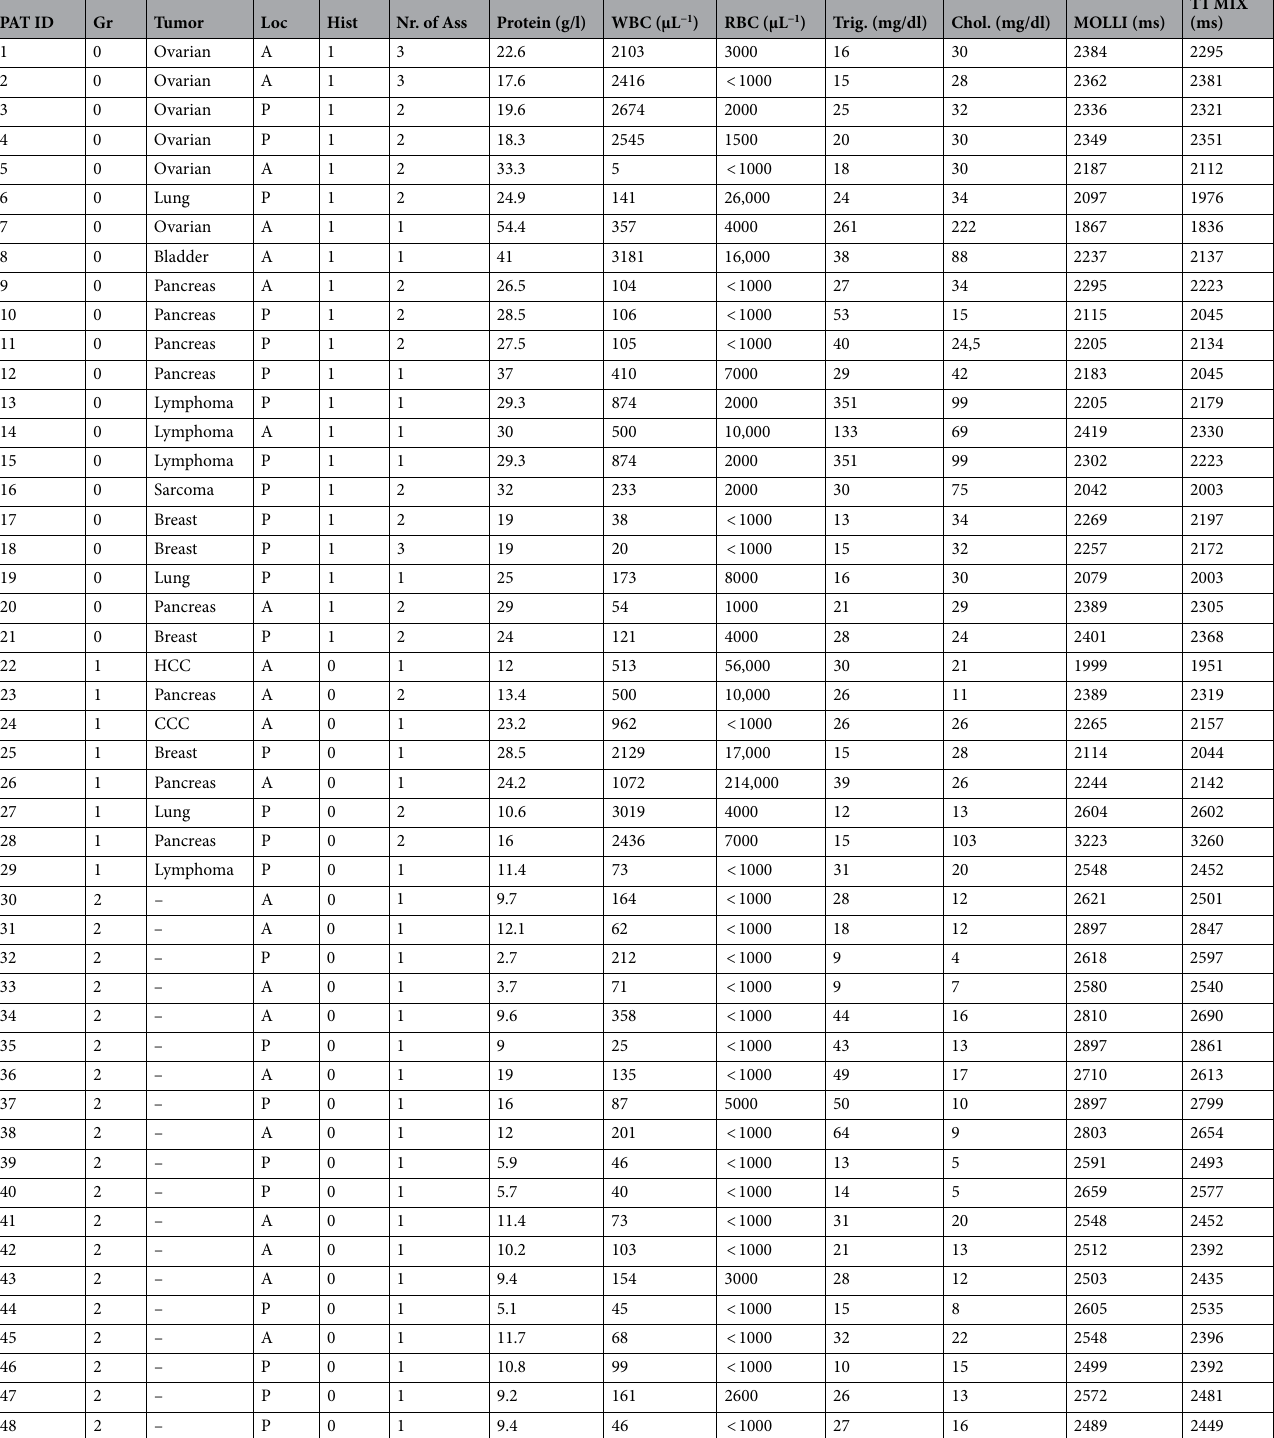
Table 1. Overview of tumor etiology (Tumor) and location (Loc) of effusions (P: pleural effusion; A: ascites) from ex-vivo studies; Effusions were classified as malignant (Histo:1) if histology or cytology was